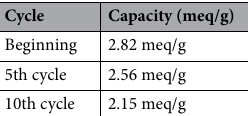
Table 2. Exchange capacities of Amberlite 252 ZU.